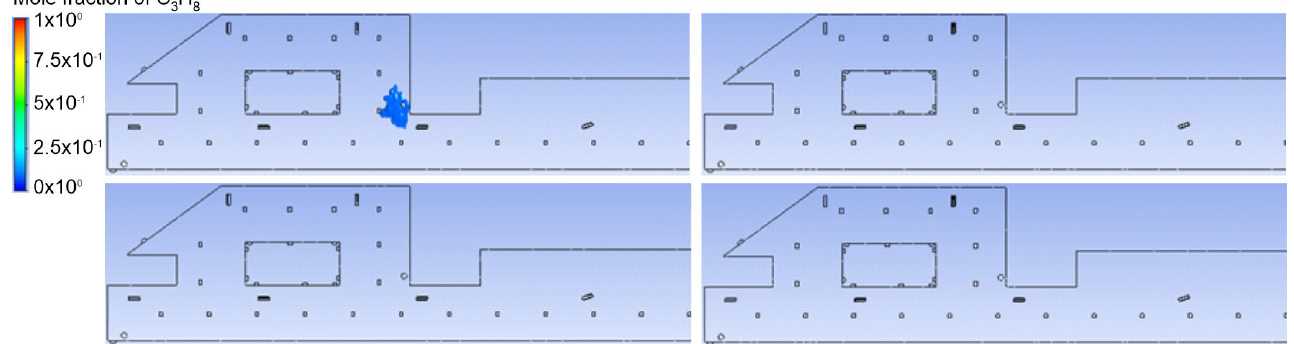
Figure 12. Upper explosive limit of LPG dispersion for B source for different time steps of 15 s, 35 s, 55 s and 70 s.